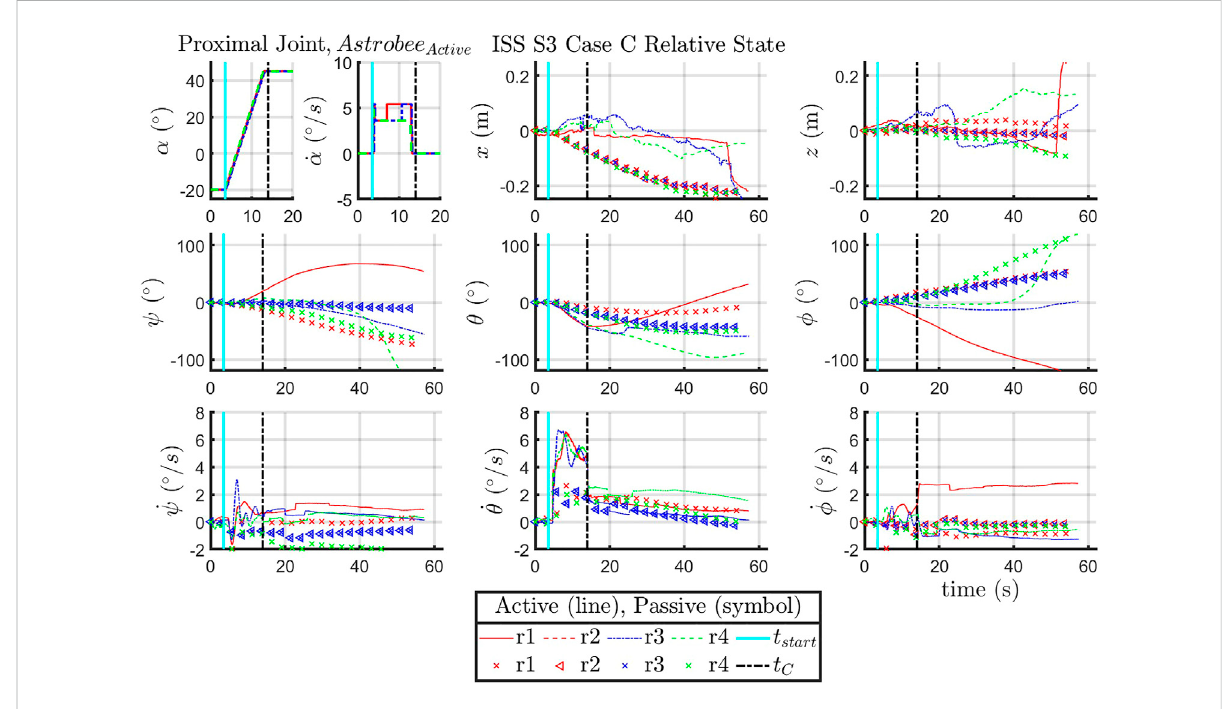
FIGURE A3 ISS: State data collected case C.